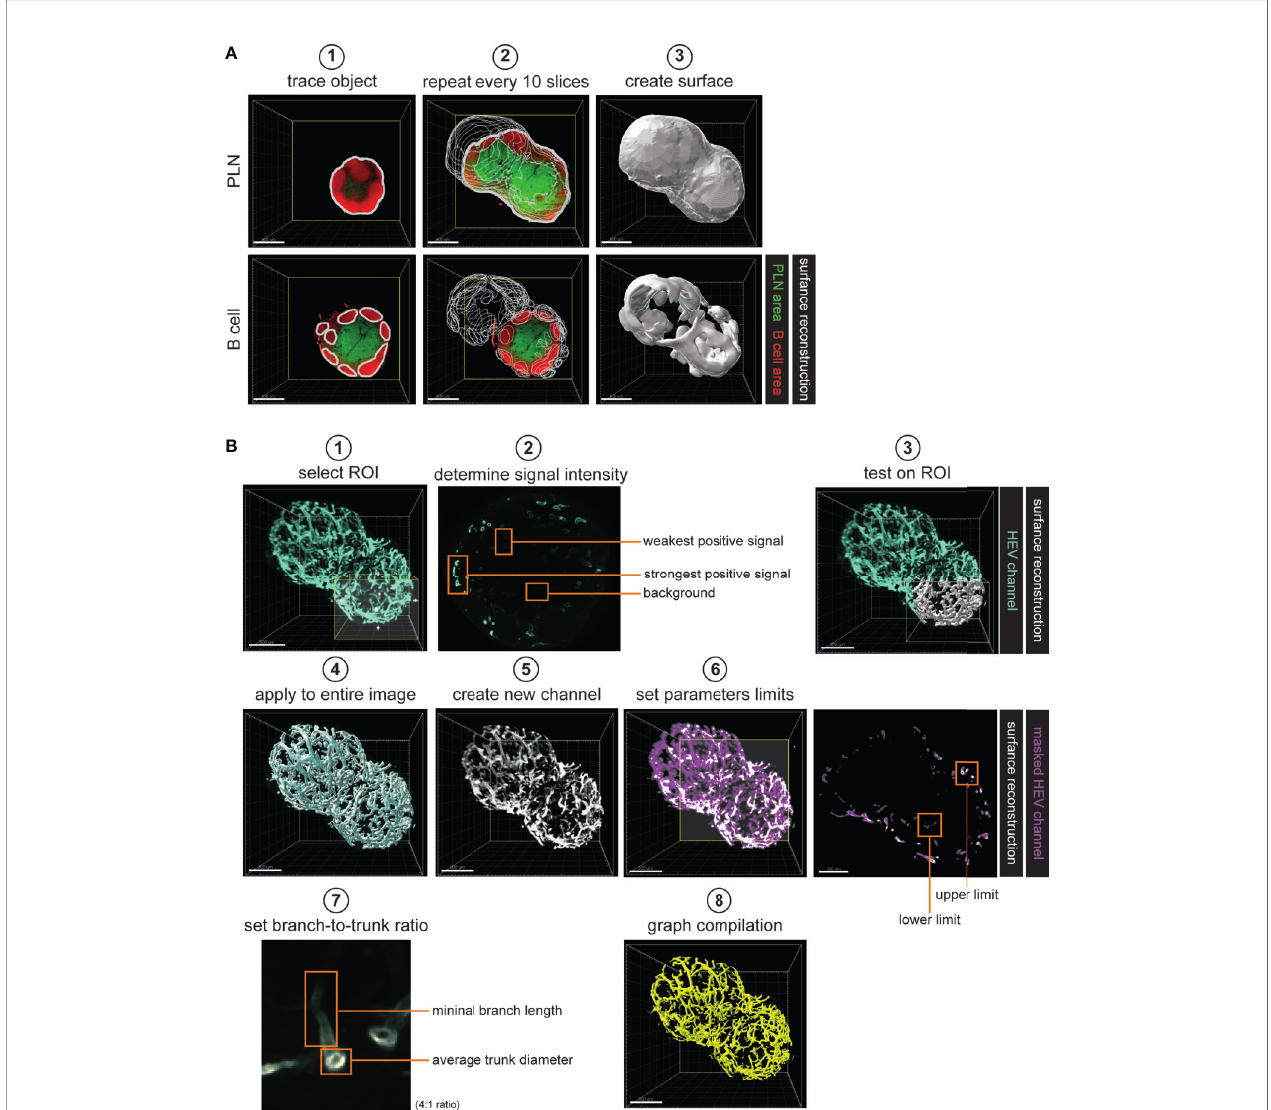
FIGURE 2 | Analytical work- fl ow. (A) 3D reconstruction of whole PLN and B cell cluster morphology. 3D volumetric surfaces were created using Imaris Surface tool, using Manual mode. Manual tracking of every 10 slices which corresponded with 50 µm sample thickness (step 1-2). The acquired surface reconstructions were used for analysis of morphology and volume of whole PLNs and B cell clusters (step 3). (B) 3D reconstruction and analysis of high endothelial vasculature. 3D volumetric surfaces were created using Imaris Surface tool, using Threshold mode (step 1-5). For each individual sample, threshold parameters were tested and set based on weakest positive signal (step 1-4). The acquired 3D surface was used to create a masked HEV channel (step 5). Masked HEV channel was used to extract data on HEV morphology by Imaris Filament Tracer tool using the Threshold (loops) mode (step 6-8). Algorithm parameters were set based on lower and upper limit of signal threshold (step 6). To exclude inference of insigni fi cant protrusions in branching point analysis a branch-to-trunk ratio of 4:1 was used (step 7). Data acquired by Surface tool was used for analysis of vessel volume (step 4). Data acquired by Filament Tracer Tool was used for analysis of vessel length and branching points (step 8). Scale bars: 500 m m ( A, B ; step 1) and 300 m m ( B ; step 3-8). PLN, peripheral lymph node; ROI, region of interest; HEV, high endothelial